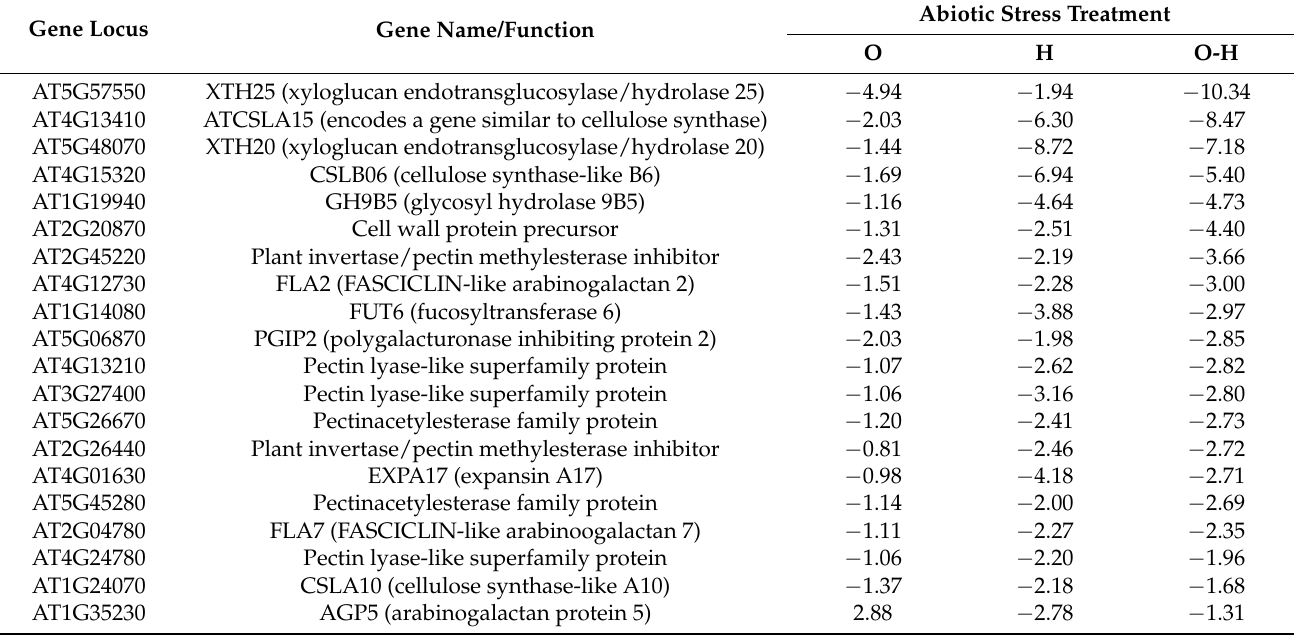
of 532 cell wall-related genes, 90 genes showed at least 1.5-fold repression and 25 genes showed at least 1.5-fold induction under the combined osmotic-heat treatment compared to control (Supplementary Table S2). These genes encode mostly for enzymes associated with cell wall metabolism. Table 2 shows 20 highly repressed cell wall-related genes taking into account the individual or the combined osmotic and heat treatments. Among the cell wall repressed genes, the xyloglucan endotransglucosylase/hydrolases 20 and 25 ( XTH20 and XTH25 ) and fasciclin-like arabinogalactan 2 ( FLA2 ), showed pronounced levels of repression under the applied abiotic stresses. XTH20 and XTH25 belong to the XTH gene family and FLA2 belongs to the FLA gene family, both including many members playing crucial roles in the synthesis and integrity of plant cell walls. Table 2. List of 20 highly repressed cell wall-related genes by the individual or combined osmotic and heat treatments. Gene Locus Gene